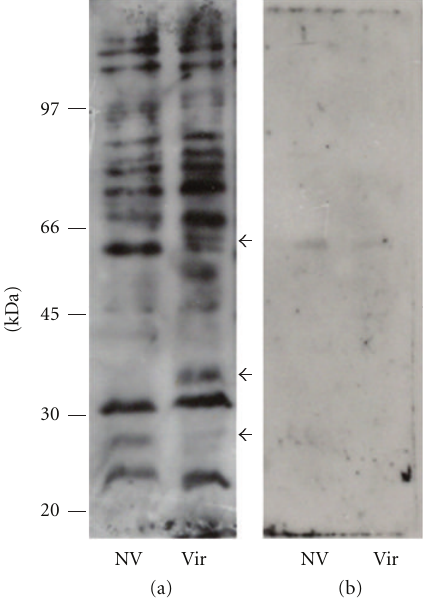
Figure 4: Binding of human PLG to L. interrogans proteins by a ffi nity blotting. Total protein extracts were resolved by 10% SDS-PAGE and electroblotted into nitrocellulose membranes. The membranes were incubated with PLG (a) or PLG + ACA (b), and the binding was detected by anti-PLG antibodies and peroxidase- conjugated antibodies. The reactivity was revealed by ECL (GE Healthcare) and exposure to X-Ray films. NV: high passage, nonvirulent L. interrogans serovar Copenhageni strain M 20; Vir: low-passage, virulent L. interrogans serovar Copenhageni strain Fiocruz L1-130. The arrows indicate reactivity protein regions seen in the virulent but absent in the nonvirulent bacterial extract. Positions of protein molecular mass markers are shown on the left.